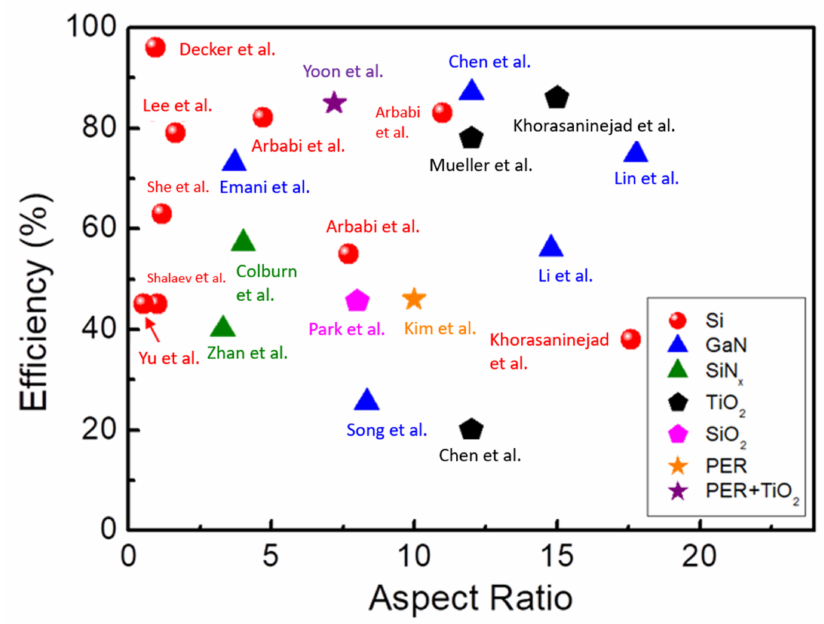
Figure 1. Aspect ratio versus efficiency of metasurfaces based on different materials. The materials silicon (Si) [37,73–80], gallium nitride (GaN) [54,63,73,74,81], silicon nitride (SiN x ) [75,76], titanium oxide (TiO 2 ) [77–79], silicon oxide (SiO 2 ) [80], polymer resin (PER) [82], and PER doping with TiO 2 [83] are marked with red dots, blue triangles, green triangles, black pentagons, pink pentagon, orange star, and purple stars,